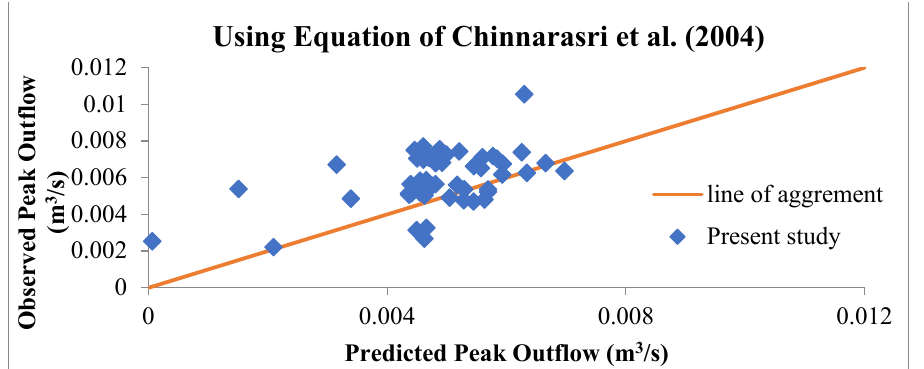
Figure 14. Variation of observed peak outflow with predicted peak outflow using Chinnarsari et al. [26] Equation (8).